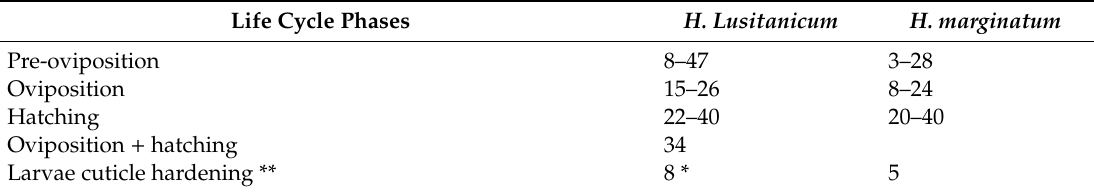
Table 3. Length (days) of the di ff erent phases of the life cycle of Hyalomma lusitanicum and Hyalomma marginatum . Numbers indicate the range of days (minimum or maximum) reported in the literature in studies performed in both laboratory and field conditions; in experimental infestation on animals or in vitro feeding assays. * Personal observations. ** Estimated length suggested by authors in the